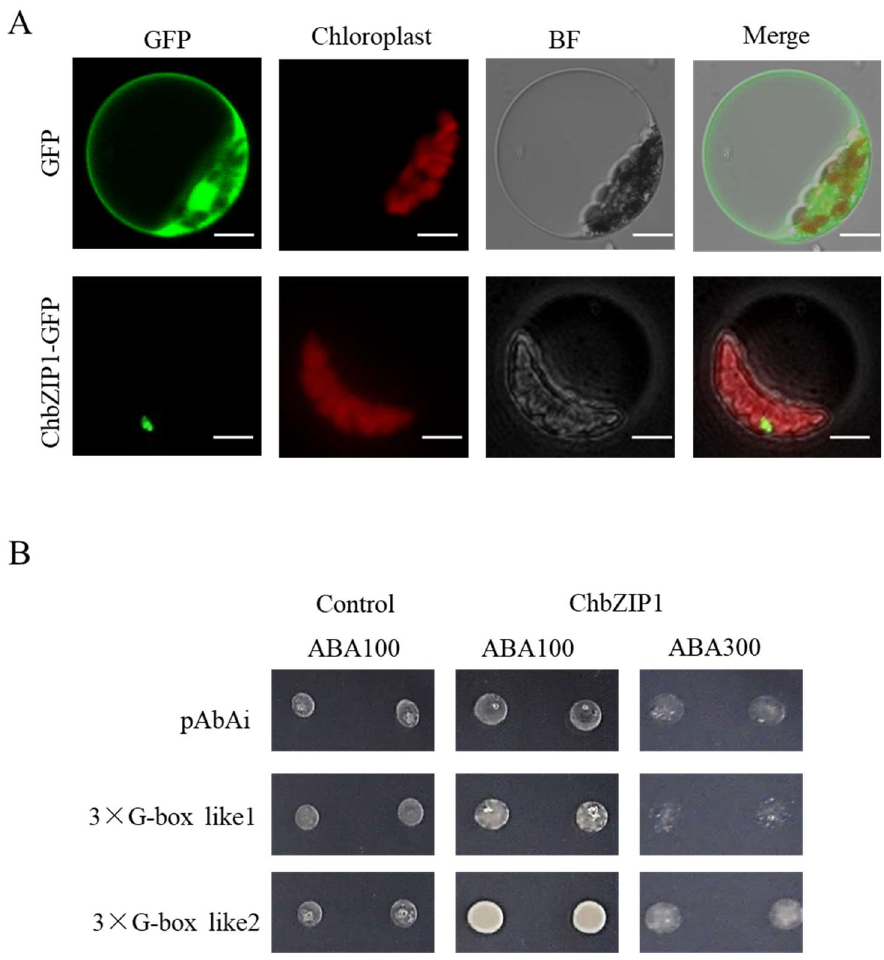
Figure 4. Subcellular localization and transactivation activity analyses of ChbZIP1. ( A ) Subcellular localization of ChbZIP1:GFP in Arabidopsis protoplasts. GFP empty vector is shown at the top. Bars = 10 µm. ( B ) ChbZIP1 binds the artificial, triple-repeated G-box 2 motifs in yeast cells at 100 and 300 ng/L concentration of aureobasidin A (AbA), whereas it fails to bind the G-box 1 and AbAi control vector.